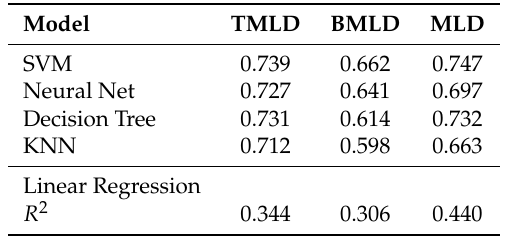
Table 3. Results for running the classification models and linear regression on the MLD, TMLD, and BLMD datasets. Details for the training and testing procedure are provided in Section